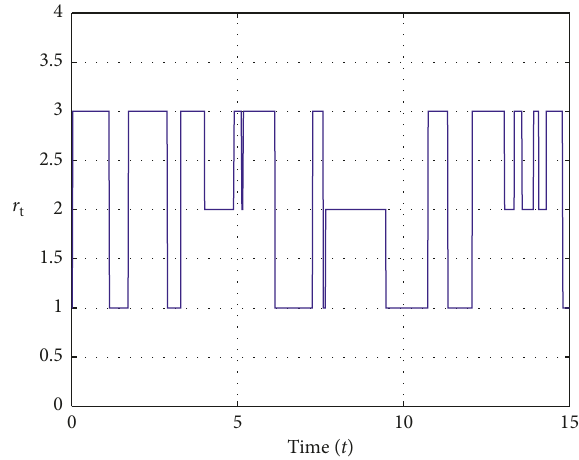
Figure 4: Semi-Markov jump signal.